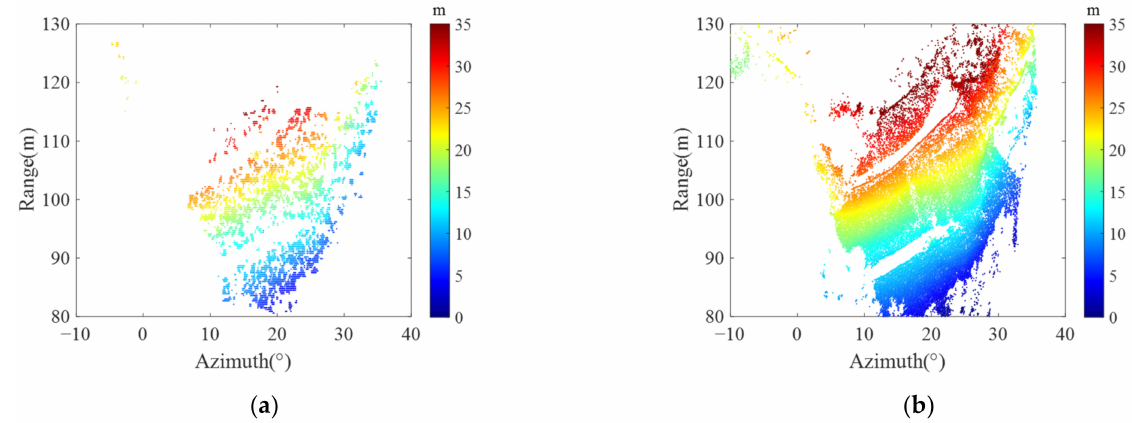
Figure 12. DEMs. ( a ) DEM generated by GB-InSAR. ( b ) DEM generated by LiDAR.